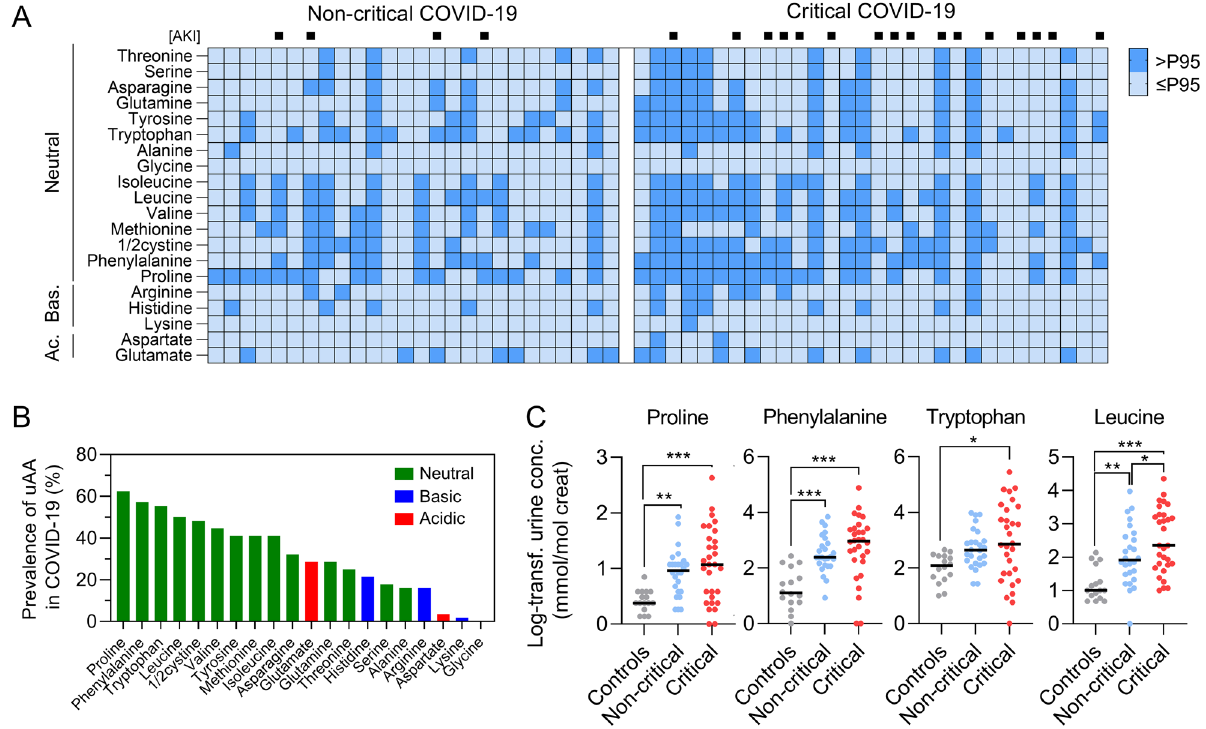
Figure 3. Prevalence and pattern of aminoaciduria in COVID-19. ( A ) Heatmap of aminoaciduria in COVID- 19 patients. Presence (dark blue) of aminoaciduria was defined as a concentration above the 95th percentile of log-transformed values in healthy controls. Dark blue (vs. light blue) cells indicate presence (vs. absence) of aminoaciduria, for the 20 classical amino acids. Patients with acute kidney injury (AKI) are identified by a black square on top of the heatmap. Bas., basic; Ac., acidic. ( B ) Prevalence of aminoaciduria in COVID-19. Neutral, basic and acidic amino acids are indicated in green, blue and red, respectively. ( C ) Comparison of log-transformed urinary levels of the most prevalent amino acids among controls (grey), non-critical (blue) and critical (red) COVID-19 patients. Data are individual values and medians. Comparisons using a one-way ANOVA followed by Holm-Sidak correction for multiple